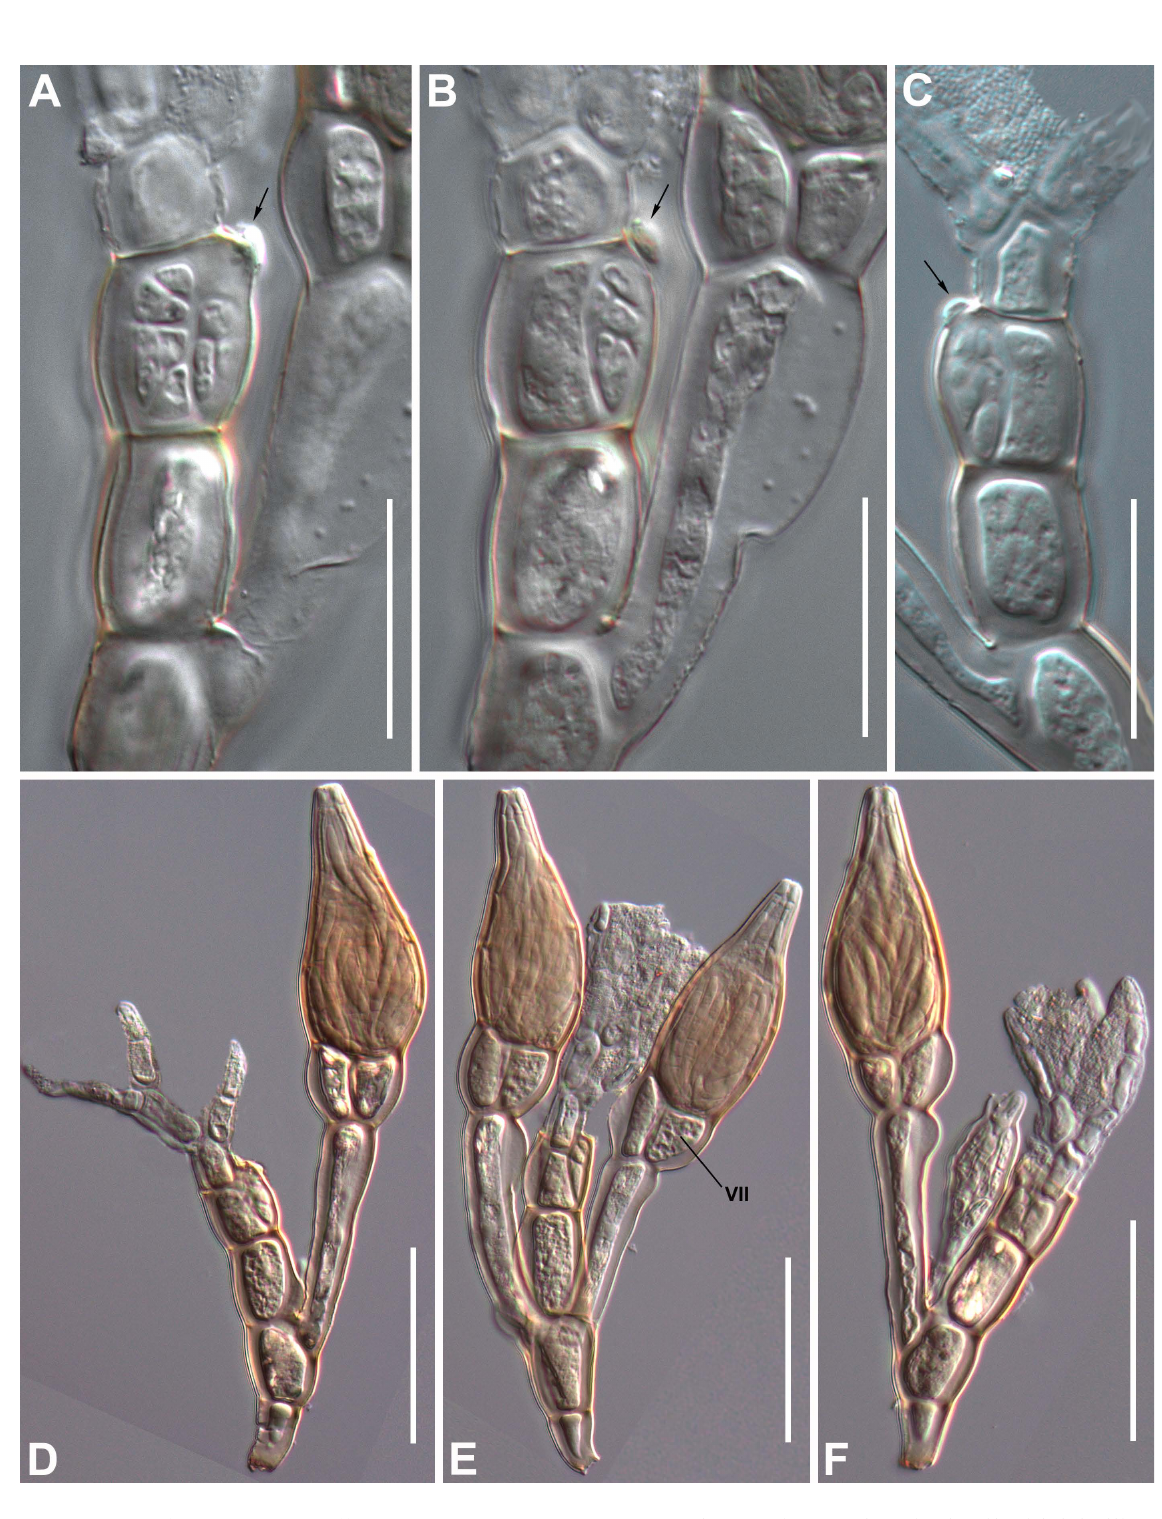
Fig. 78. Cantharomyces papillatus Santam. sp. nov. A – C . Basal area of appendage in detail with labelling of papilla-like prominence which represents the antheridial efferent neck (arrows). D – F . Mature thalli with labelled cell VII in E. Scale bars: A–C = 20 µm; D–F = 50 µm. Photographs from slides ZMUC C-F-124208